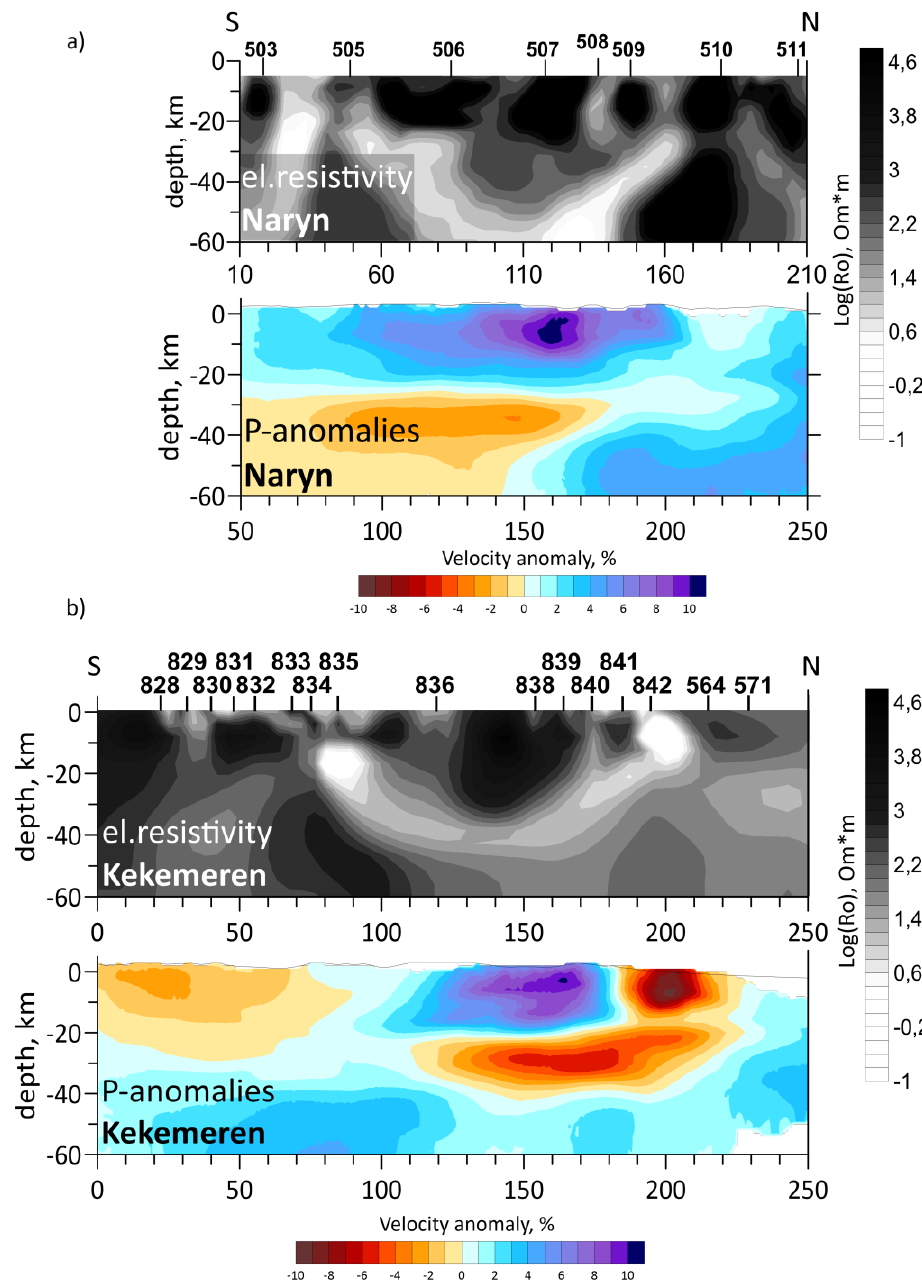
Figure 10. Comparison of the MTS (black-and-white models) and ST (color models) results at the Naryn ( a ) and Kekemeren ( b ) profiles.